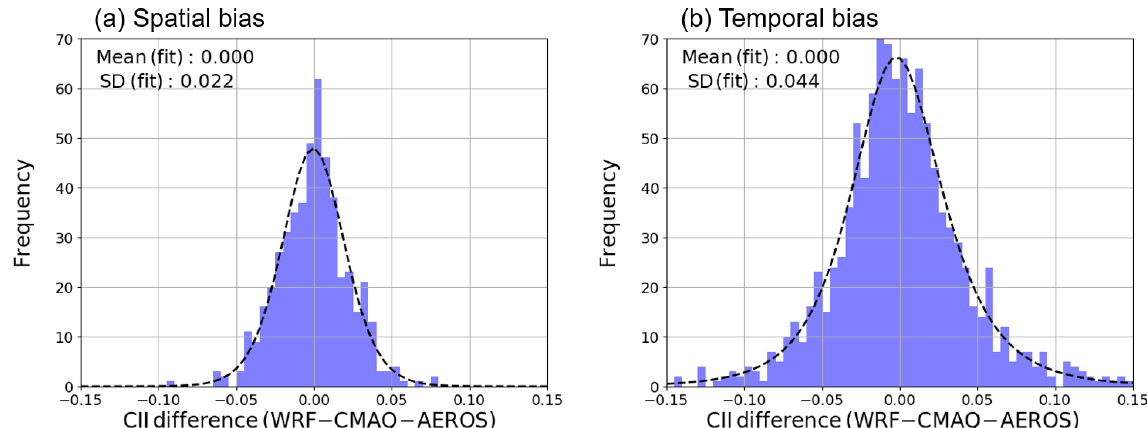
Figure 4. Histogram of the CII difference between the WRF–CMAQ model and the AEROS measurements. (a) The CII mean values of all days in the study period are compared for each municipality. (b) The CII mean values of all Japanese municipalities are compared for each day. The dashed line represents the fitting of the histogram of the CII difference by the Johnson SU function. The mean and standard deviation (1 σ ) values of the fitting function are shown in the upper left of each